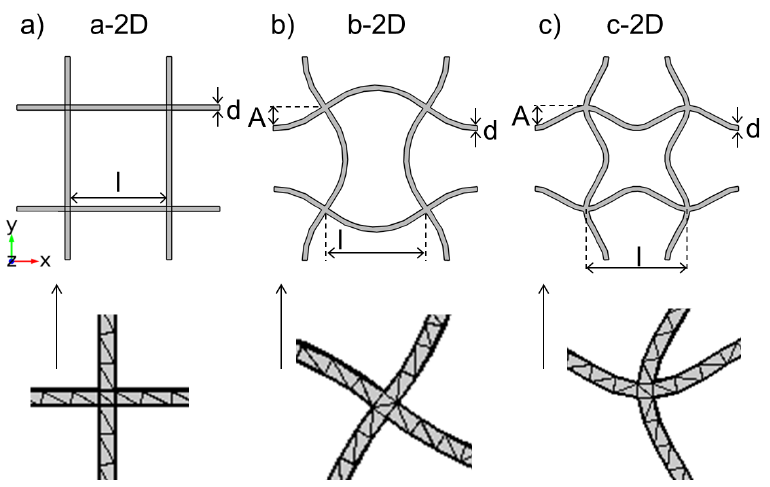
Figure 2. Two-dimensional unit cells and FEM mesh: ( a ) Basic cell; ( b ) Eigenmode with chiral nodes; ( c ) Eigenmode with fixed